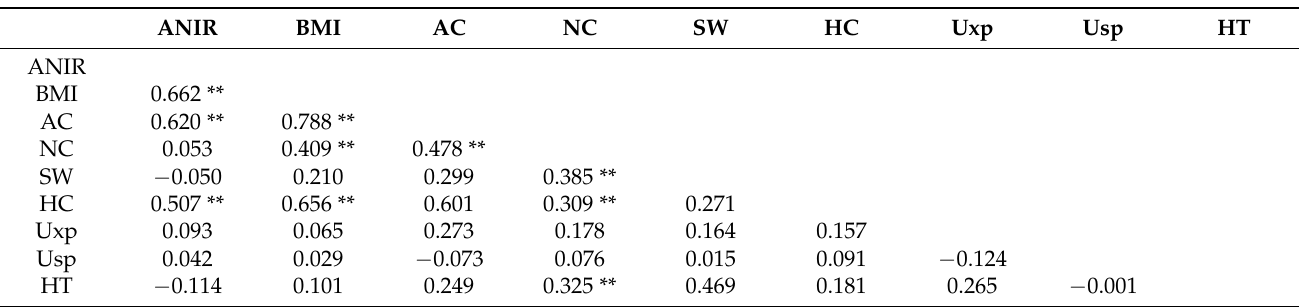
Table 3. Correlation between depth to peritoneum on CV12 and anthropometric parameters in the study population.